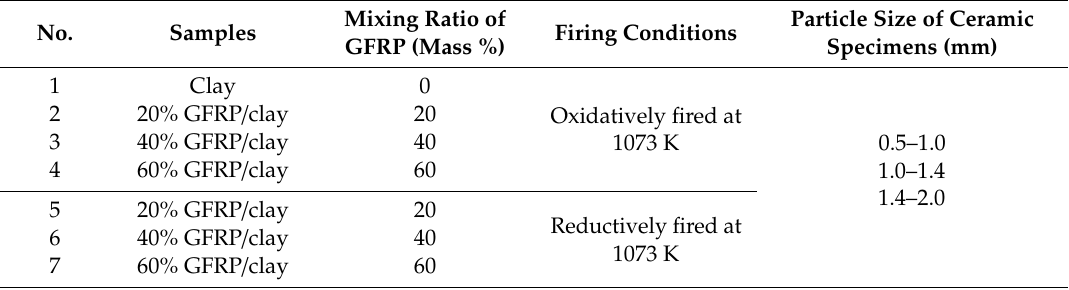
Table 2. Manufacturing conditions for the granular